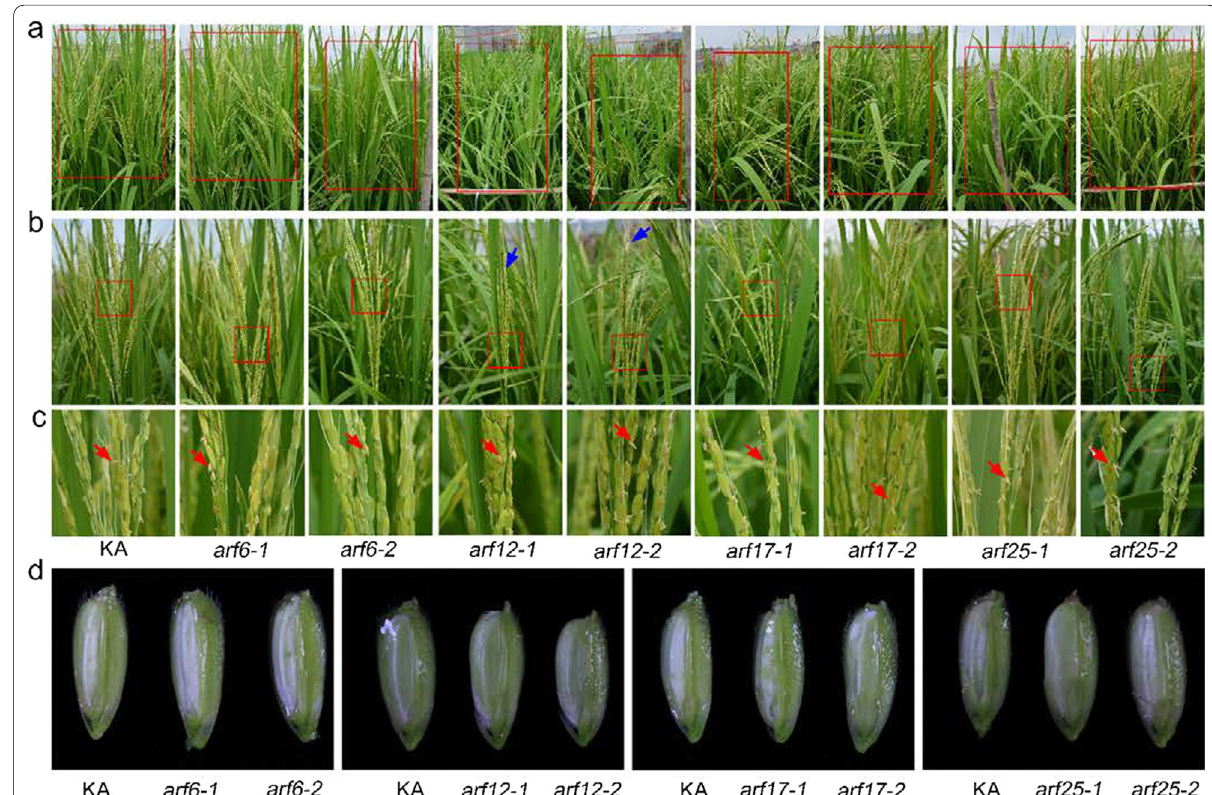
Fig. 4 Panicle and flower phenotypes of the ARF single mutants. a ‑ c Panicles of KA and ARF single mutants. Overview of the panicles ( a ), Close‑up view of the panicles ( b , c ). Blue arrows indicate aborted apical spikelets. Red arrows indicate the anthers that move out from the flowers. d The inner view of the flowers at the later grain filling